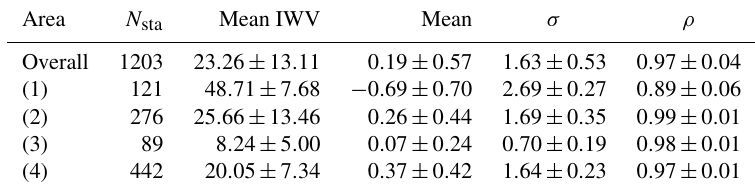
Table B1. Similar to Table 1 but for ERA5 only with 6-hourly